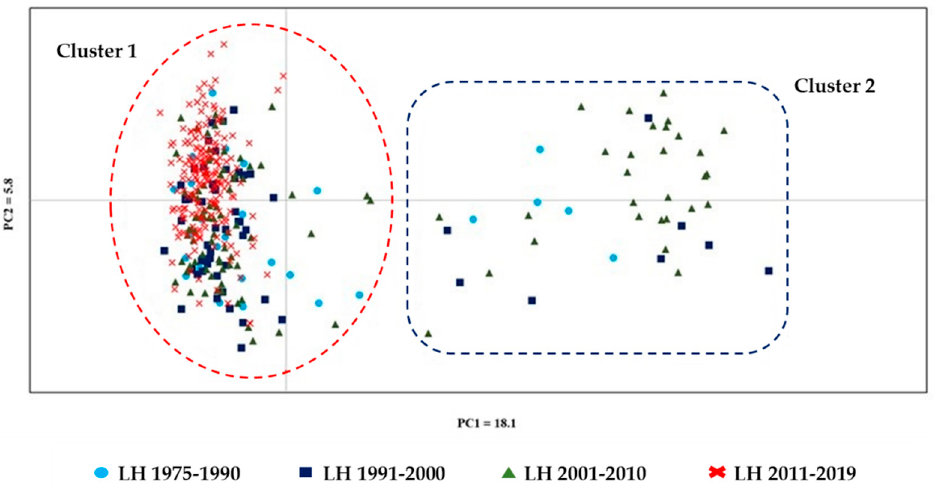
Figure 4. Graphical dispersion of inter-population distances of the LH bred in Italy. The Cartesian axes obtained by the Principal Coordinates Analysis (PCoA) were based on the dissimilarity matrix of 384 related and unrelated